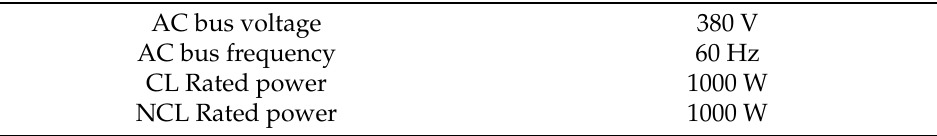
Table 1. Microgrid system parameters.